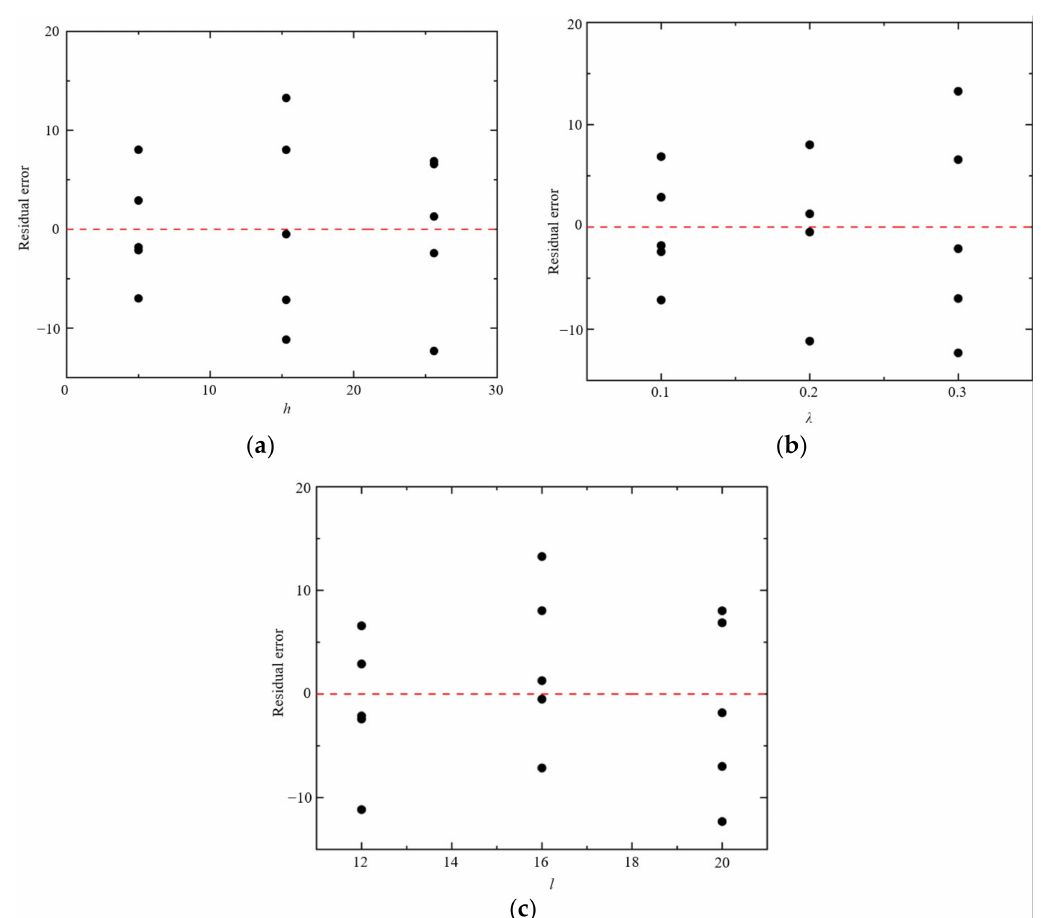
Figure 15. Scatterplot of the residuals vs. responses. ( a ) Scatterplot of the residuals vs. h ; ( b ) scatterplot of the residuals vs. l ; ( c ) scatterplot of the residuals vs. λ